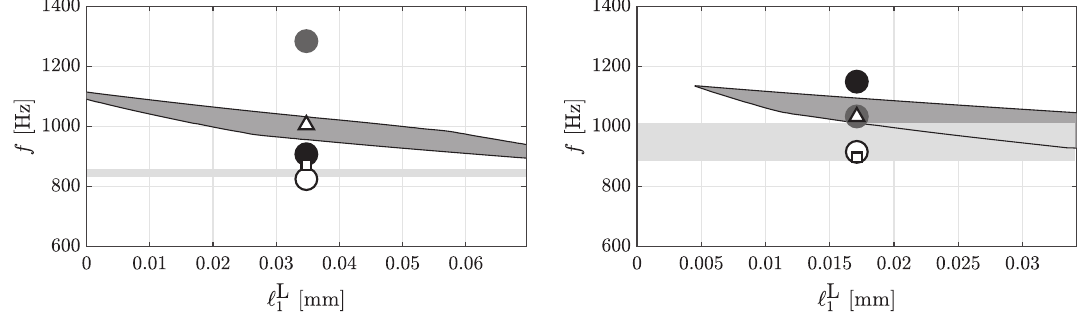
. The fi rst three tonehole 1